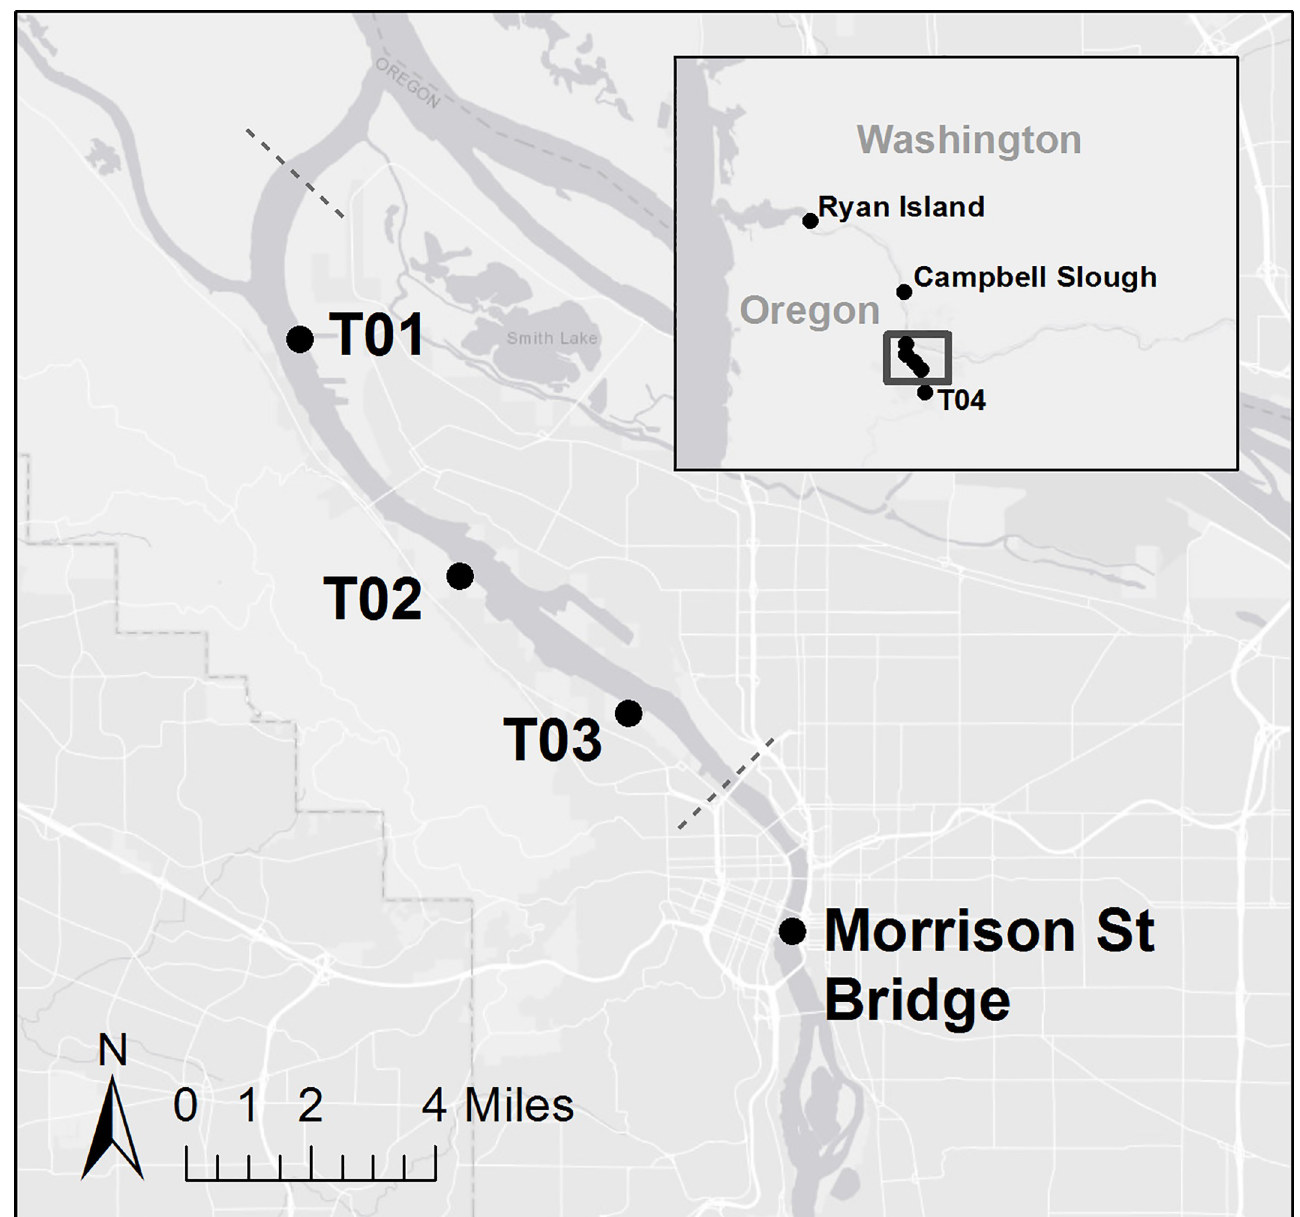
Fig 2. Map of juvenile Chinook salmon sampling sites within Portland Harbor. Inset shows up- and downstream sampling sites. Dashed lines show approximate boundaries of Superfund Site [26,